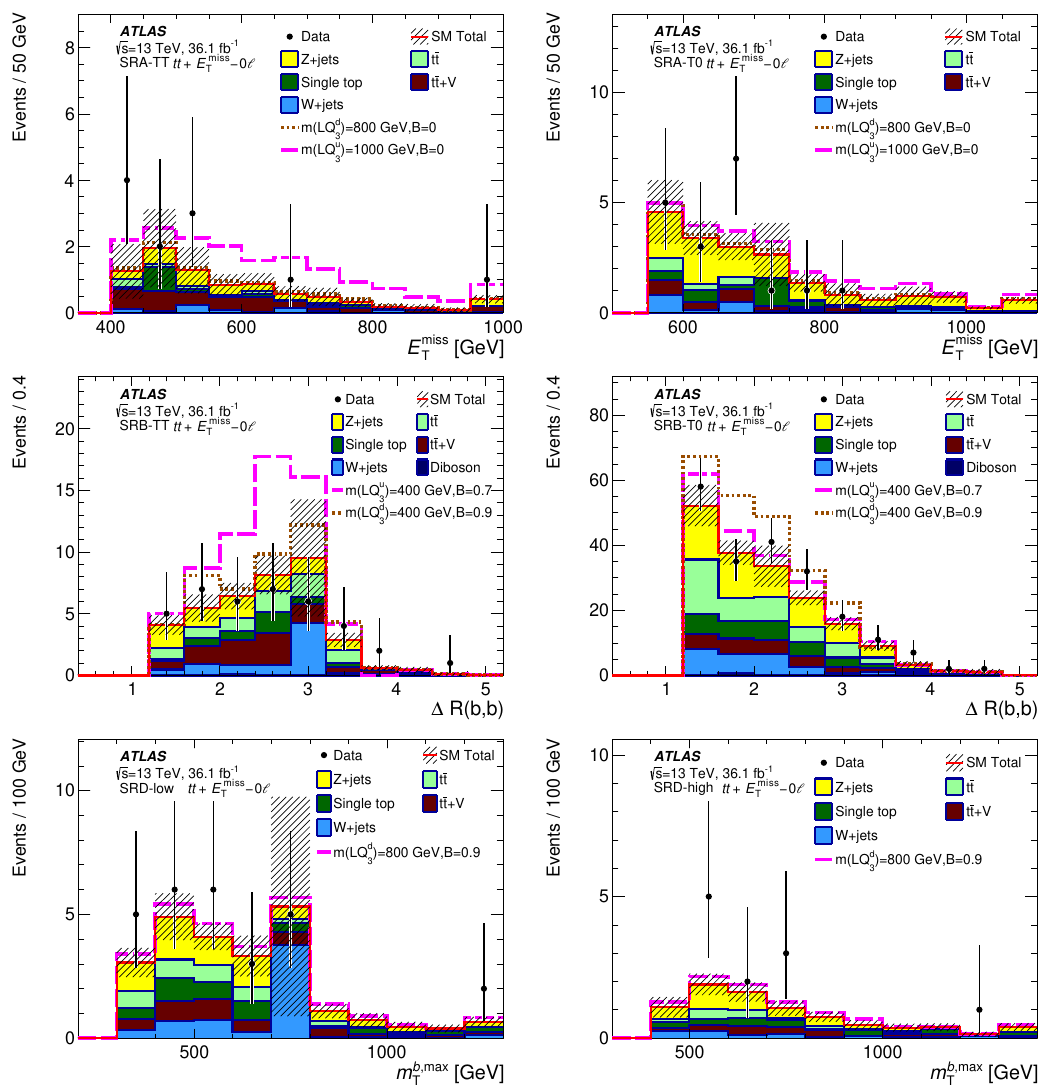
Figure 11 . Distributions of E miss in SRA (upper panels) and (cid:1) R ( b; b ) in SRB (middle panels) T separately for the individual top reconstruction categories TT and T0 and the m b; max distribution T in SRD-low and SRD-high (lower panels). The expected SM backgrounds are normalized to the values determined in the (cid:12)t. The expected number of signal events for di(cid:11)erent LQ masses and branching ratios B is added on top of the SM prediction. The last bin contains the over(cid:13)ow events.